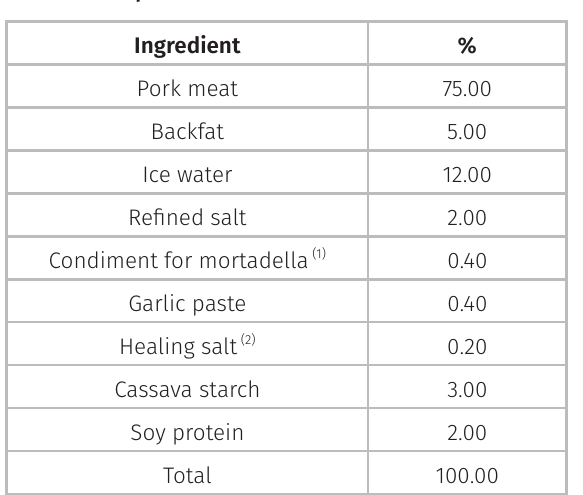
Table II. Composition of